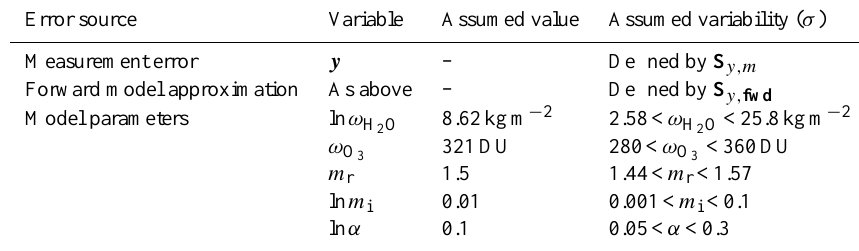
SD: standard deviation. Table 5. Reference values and variabilities assumed for error analysis. Error